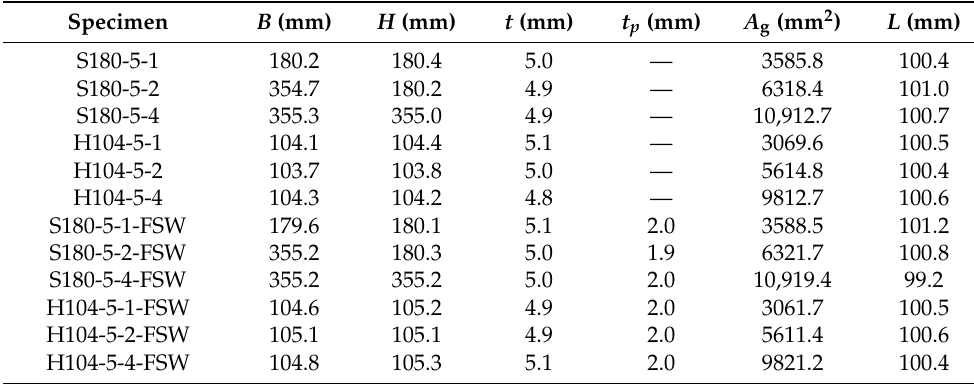
Figure 3. Welding process and clamping device. Table 1. Measured dimensions of honeycomb specimens.